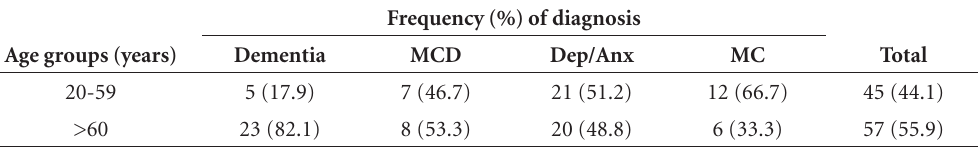
Table 2. Frequency of diagnosis by two age groups.